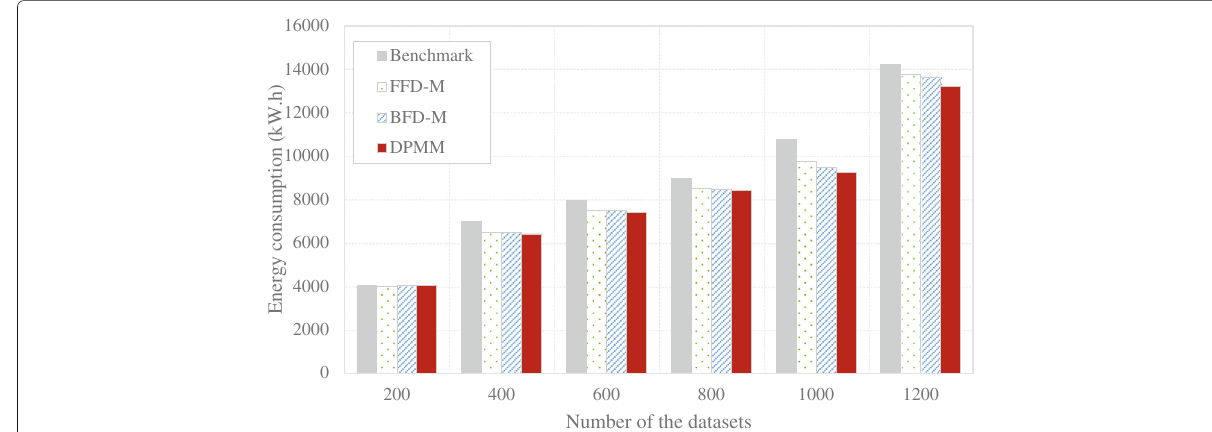
Fig. 8 Comparison of energy consumption in MCP of Benchmark, FFD-M, BFD-M, and DPMM at different dataset